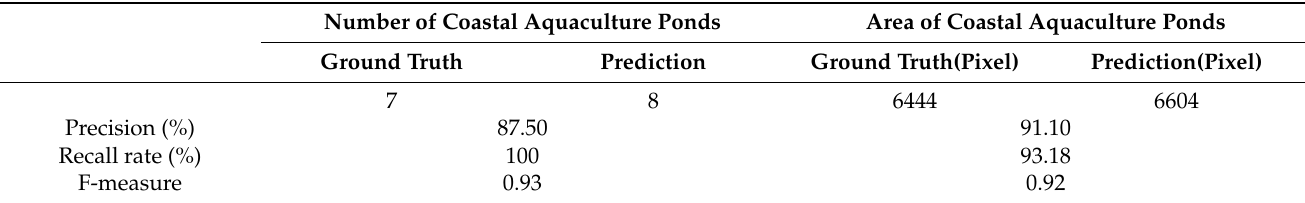
Table 3. Accuracy evaluation of coastal aquaculture ponds extraction in Daishan Island,